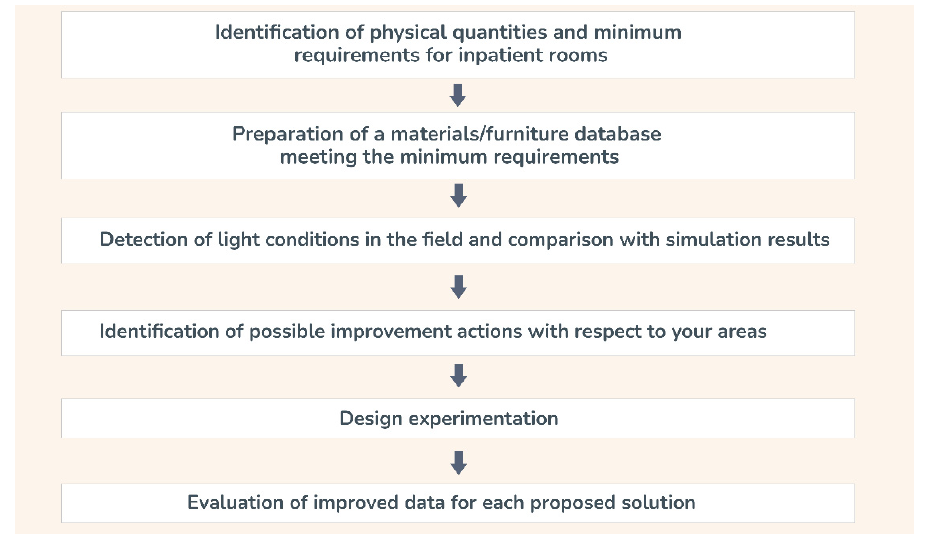
Figure 1. Assessment methodology.